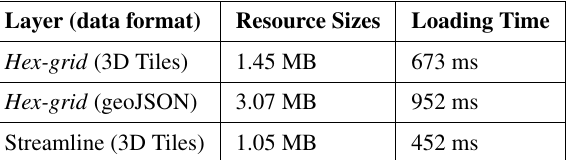
Figure 8. Visualization of pressure at roof top level (slice height = 5 m) showing the same building block as in Figure 7. Wind pressure layer was requested from the 3DPS as a hex-grid (hexagon width of 5 m) using 3D Tiles (top) and geoJSON (bottom). Table 2. Average loading times (out of 10 iterations), measured using Google Chrome Developer Tools.